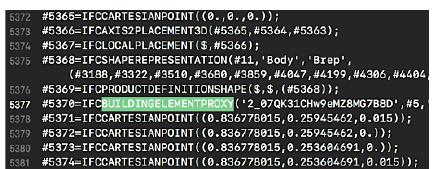
Figure 6. BIM Server file customization